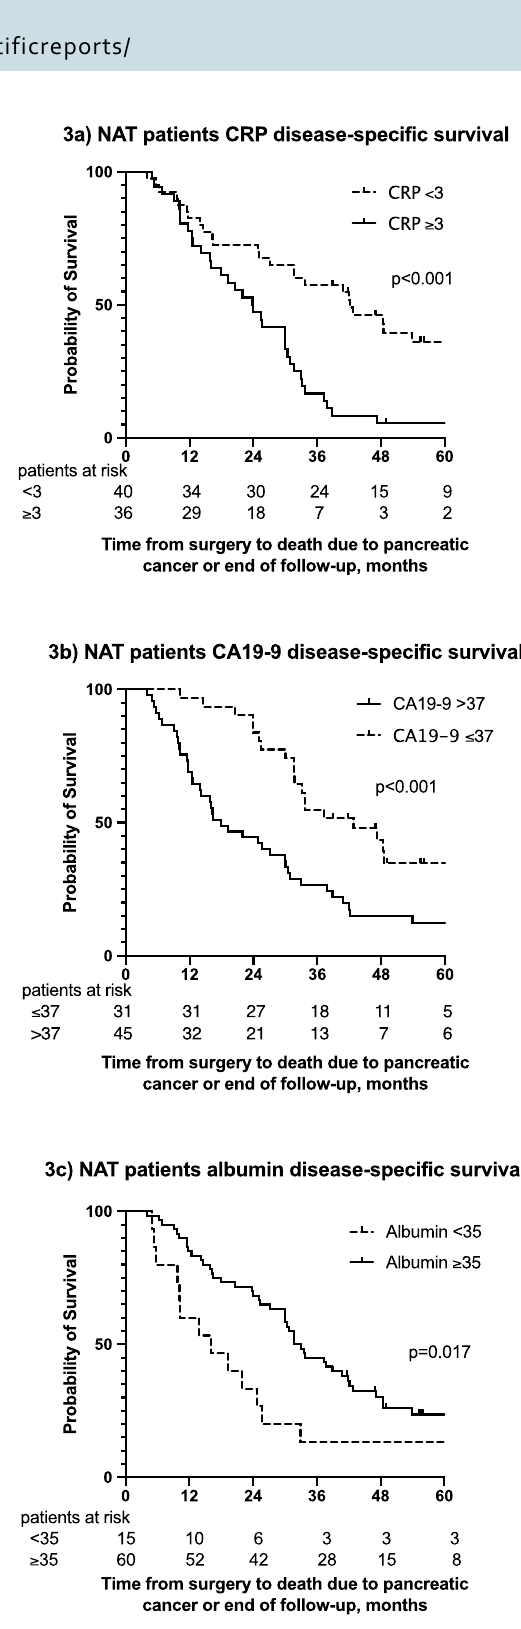
Figure 3. ( a ) Disease-specific survival (DSS) for NAT patients according to CRP levels. Median DSS were 42 m (95% CI 26–58 m) and 24 months (95% CI 17–31 months). ( b ) DSS for NAT patients according to CA19-9 levels. Median DSS were 43 m (95% CI 26–59 m) and 18 m (95% CI 10–26 m). ( c ) DSS for NAT patients according to albumin levels. Median DSS were 32 m (95% CI 28–35 m) and 16 m (95% CI 5–27